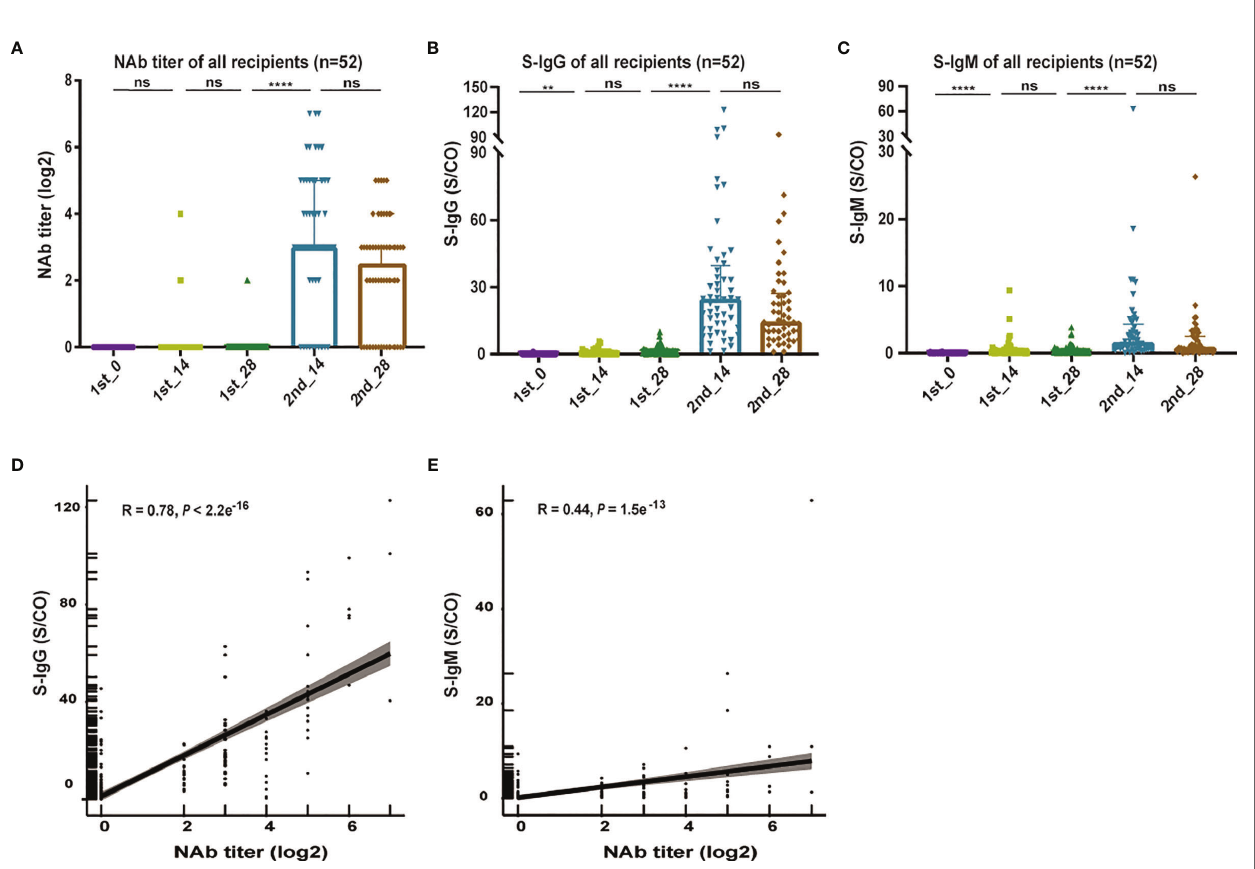
FIGURE 2 | Overall distribution of antibody levels in serum samples at different timepoints after vaccination. (A – C) , Overall distribution of anti-SARS-CoV-2 Nab titers (A) , S-IgG levels (B) and S-IgM levels (C) at different timepoints after vaccination. (D) Correlation between the NAb titer and S-IgG levels. (E) Correlation between the NAb titer and S-IgM levels. A nonparametric Kruskal-Wallis rank-sum method was employed to compare differences in multiple groups. Correlations were analyzed by Pearson correlation coef fi cients. Statistical signi fi cance of the difference between groups is denoted as ** for P < 0.01, and **** for P < 0.0001. NAb, anti-SARS- CoV-2 neutralizing antibody; S-IgG, SARS-CoV-2 spike-speci fi c immunoglobulin G; S-IgM, SARS-CoV-2 spike-speci fi c immunoglobulin M; ns, not signi fi